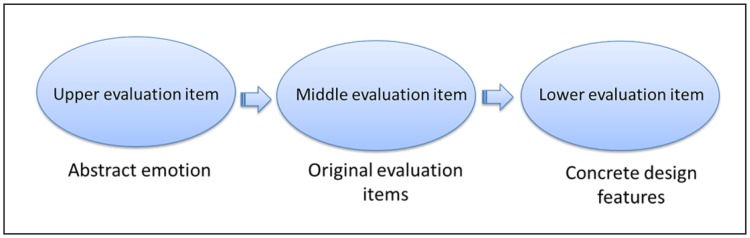
Formation of EGM.